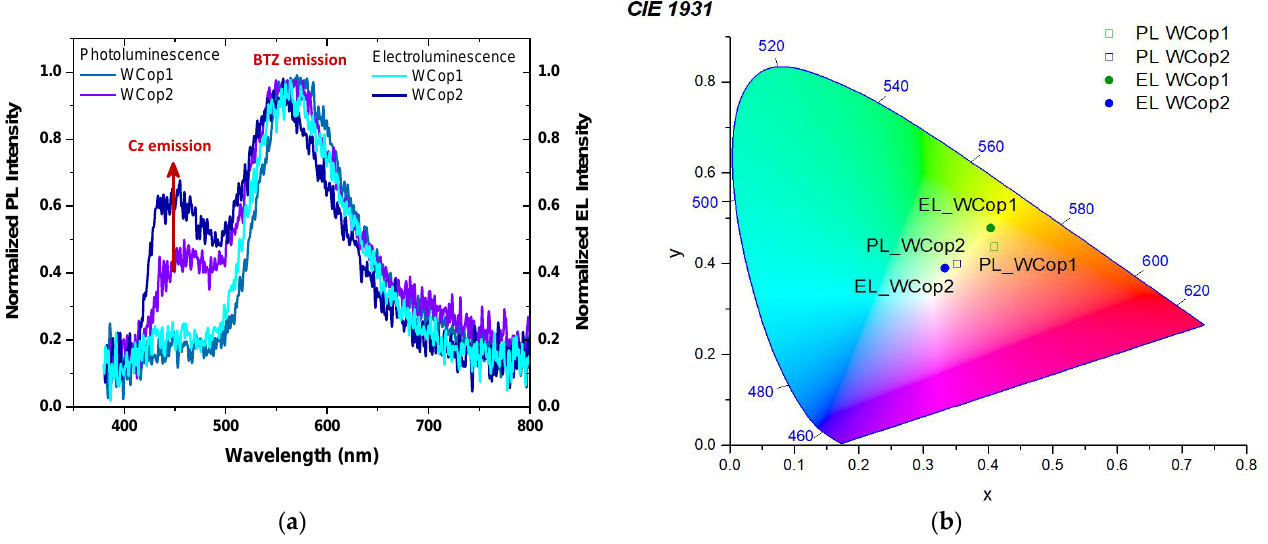
Figure 9. ( a ) Normalized PL and EL spectra of the studied white light emitting copolymer films. ( b ) CIE diagram of PL and EL emission of the studied white copolymers.